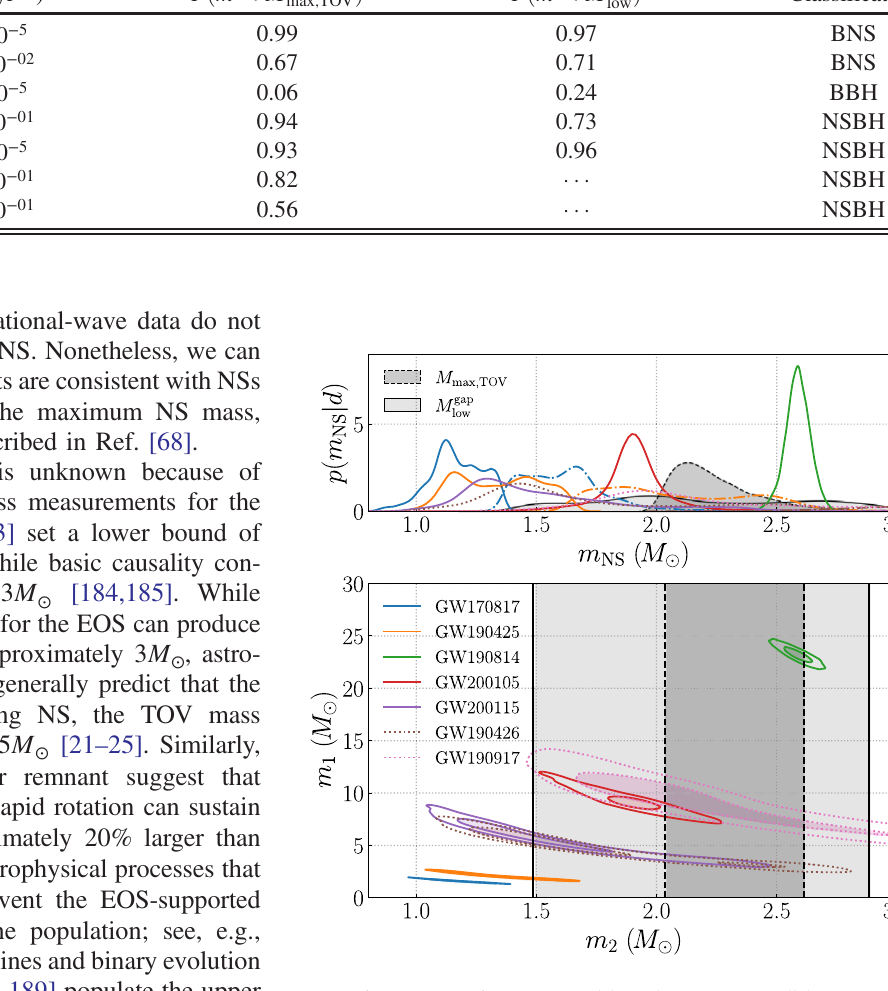
2 . 21 þ 0 . 40 − 0 . 18 M ⊙ max ; TOV ¼